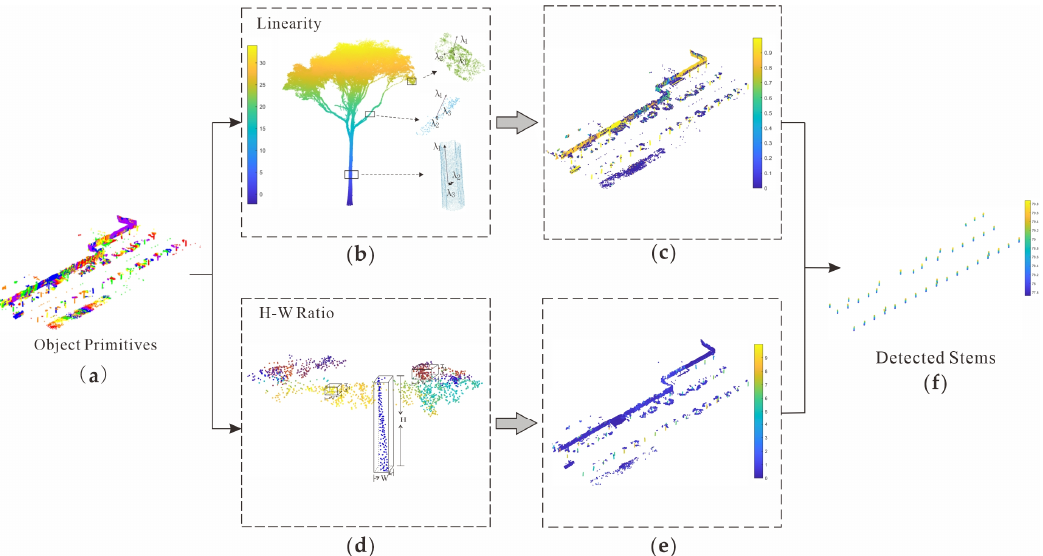
Figure 4. Stem detection using geometric characteristics of object primitives: ( a ) is the initial object primitives. The linearity and H-W ratio of each object primitive are calculated and shown in ( b – e ), respectively. The detected stems are shown in ( f ).